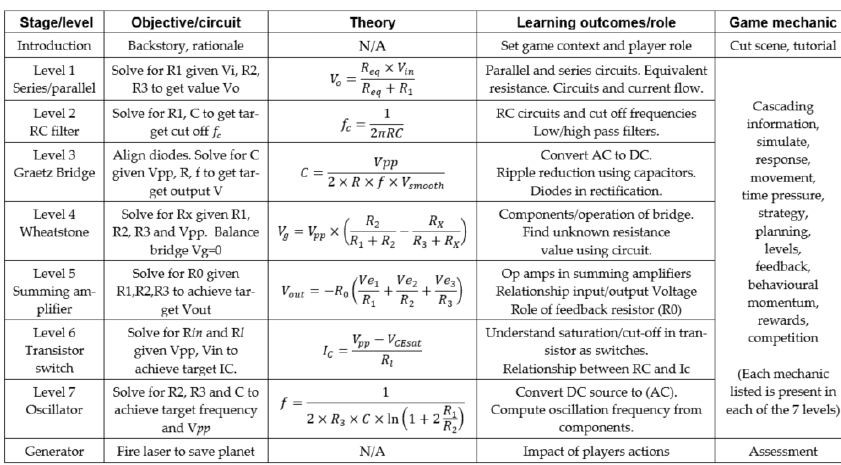
Table 2. Game stages and levels with player objectives